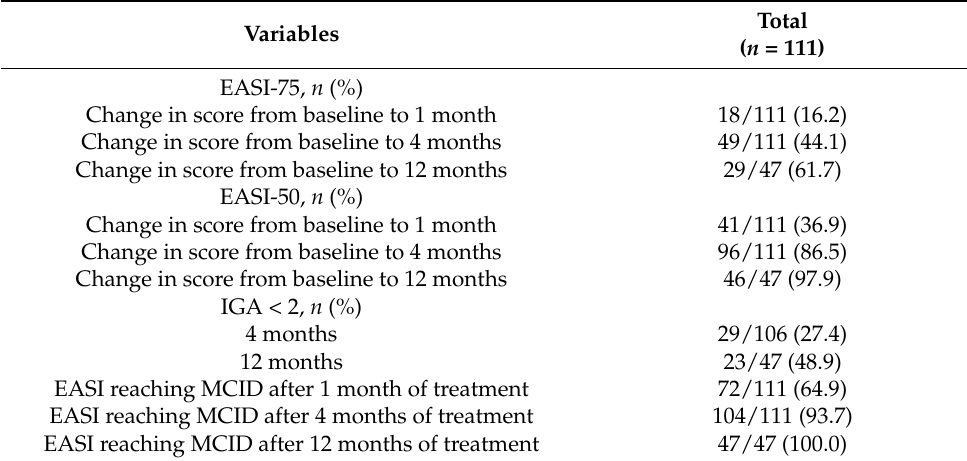
Table 2. Effectiveness of dupilumab in daily